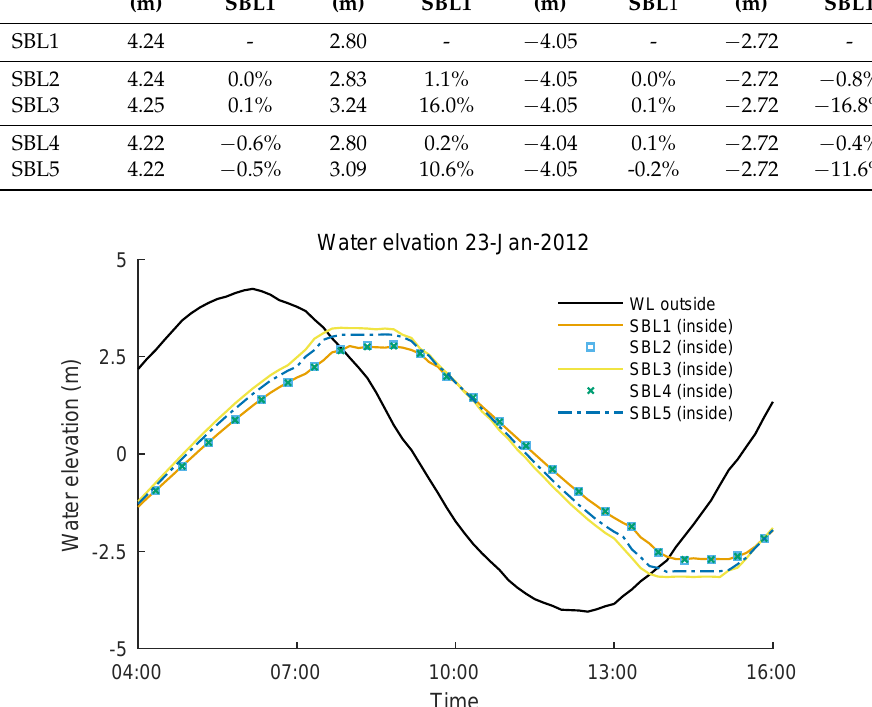
Figure 15. Comparison of water elevations inside the lagoon for the five different